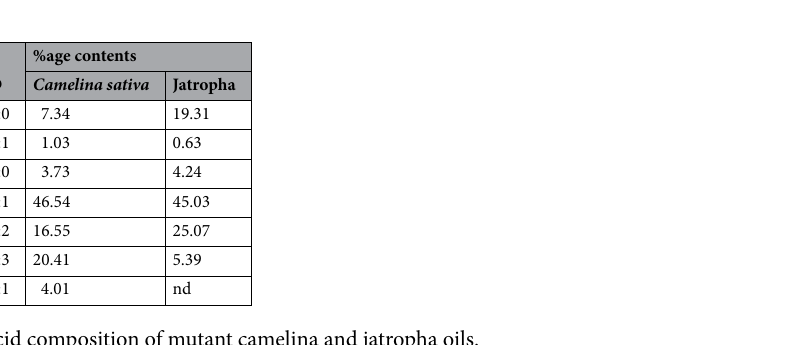
Table1. The fatty acid composition of mutant camelina and jatropha